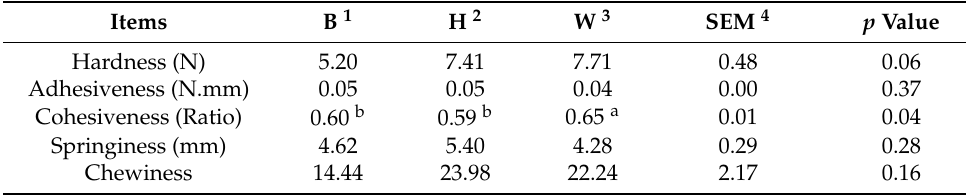
Table 4. Texture properties in egg albumen from three